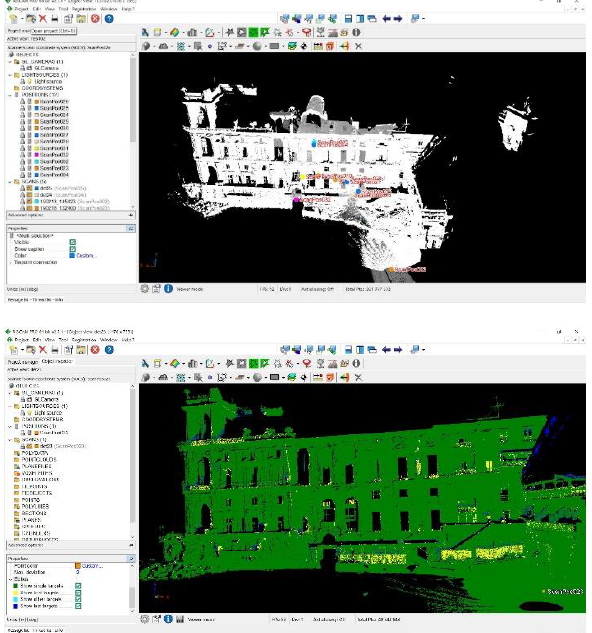
Figure 2. Point cloud in RiscanPro: color mode multiechos underscore